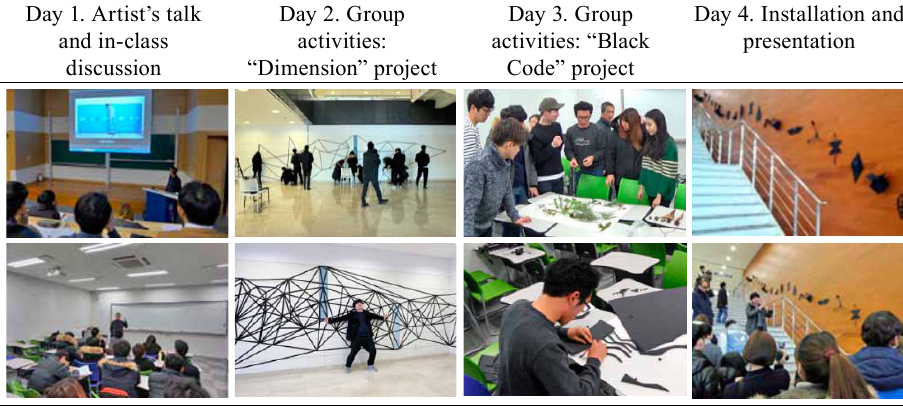
Table 6. Work process of group b (created by author) Day 1. Artist’s